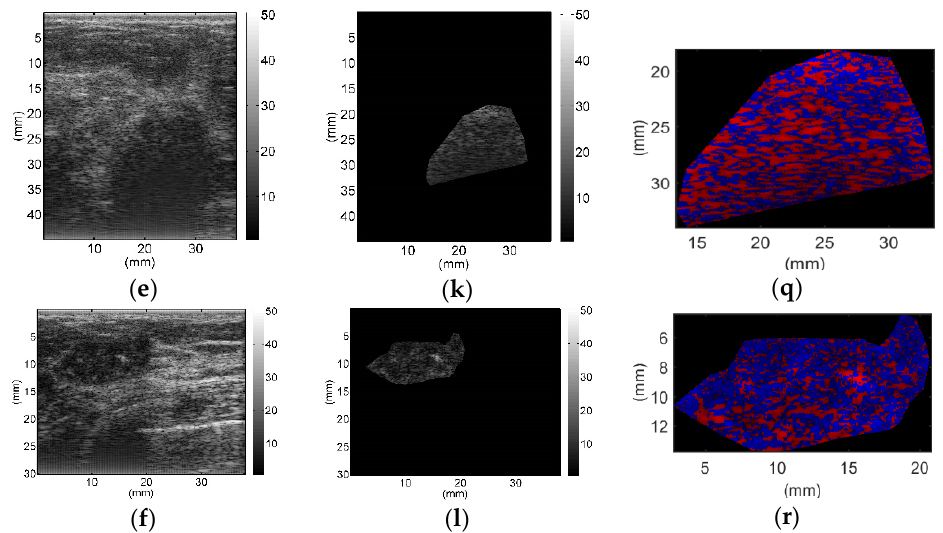
Figure 4. Typical B-mode ( a – f ), region of interest ( g – l ), and H-scan ( m – r ) ultrasound images of malignant breast tumors. H-scan images ( m – r ) correspond to the regions of interest of B-mode images ( g – l ).